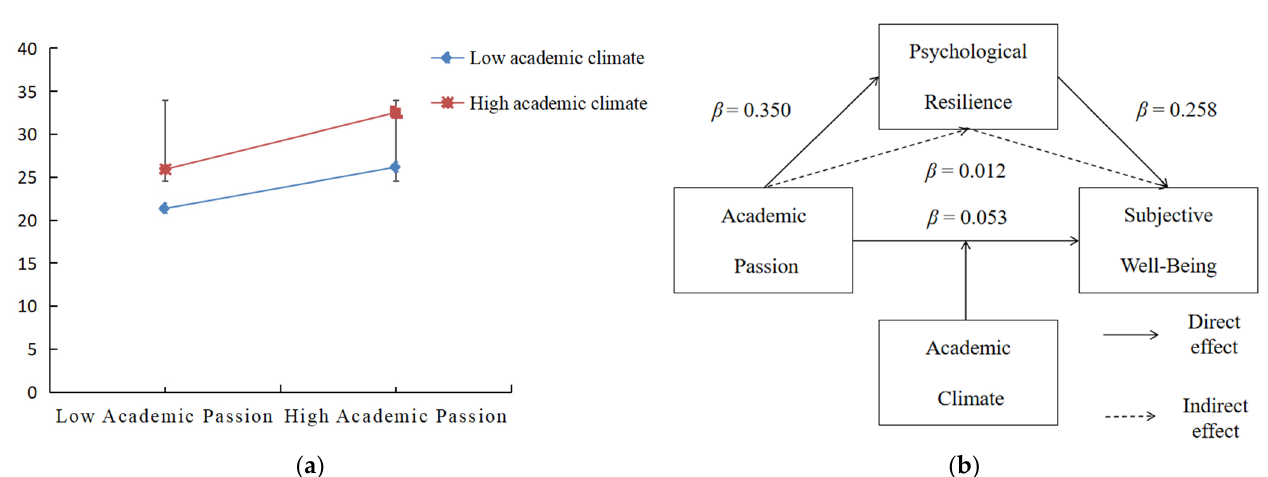
Figure 2. A diagram of the slope of the moderation effect and the mediated model with moderation. ( a ) The moderating role of the academic climate between AP and SWB. ( b ) A mediated model with moderation.